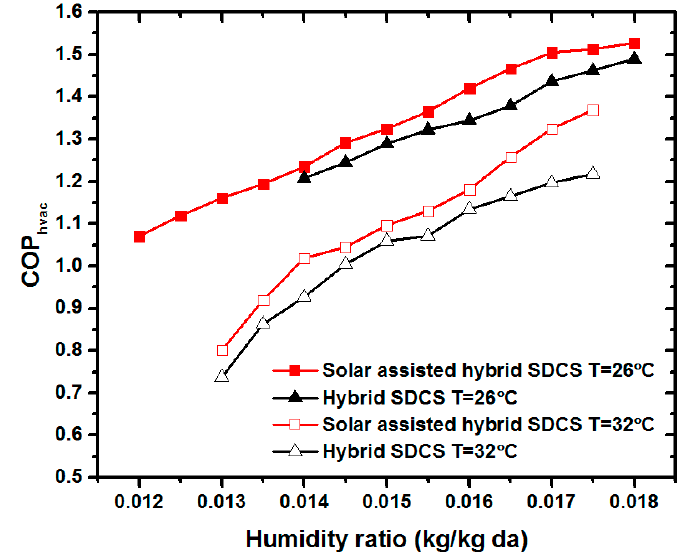
ff erent outdoor humidity